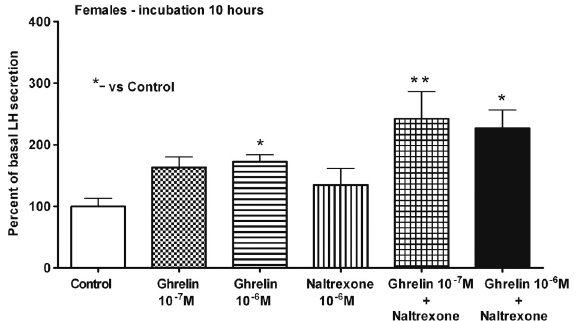
Fig. 1. Percentage of basal LH secretion from female pitu- itary cells incubated for 10 h with control medium,